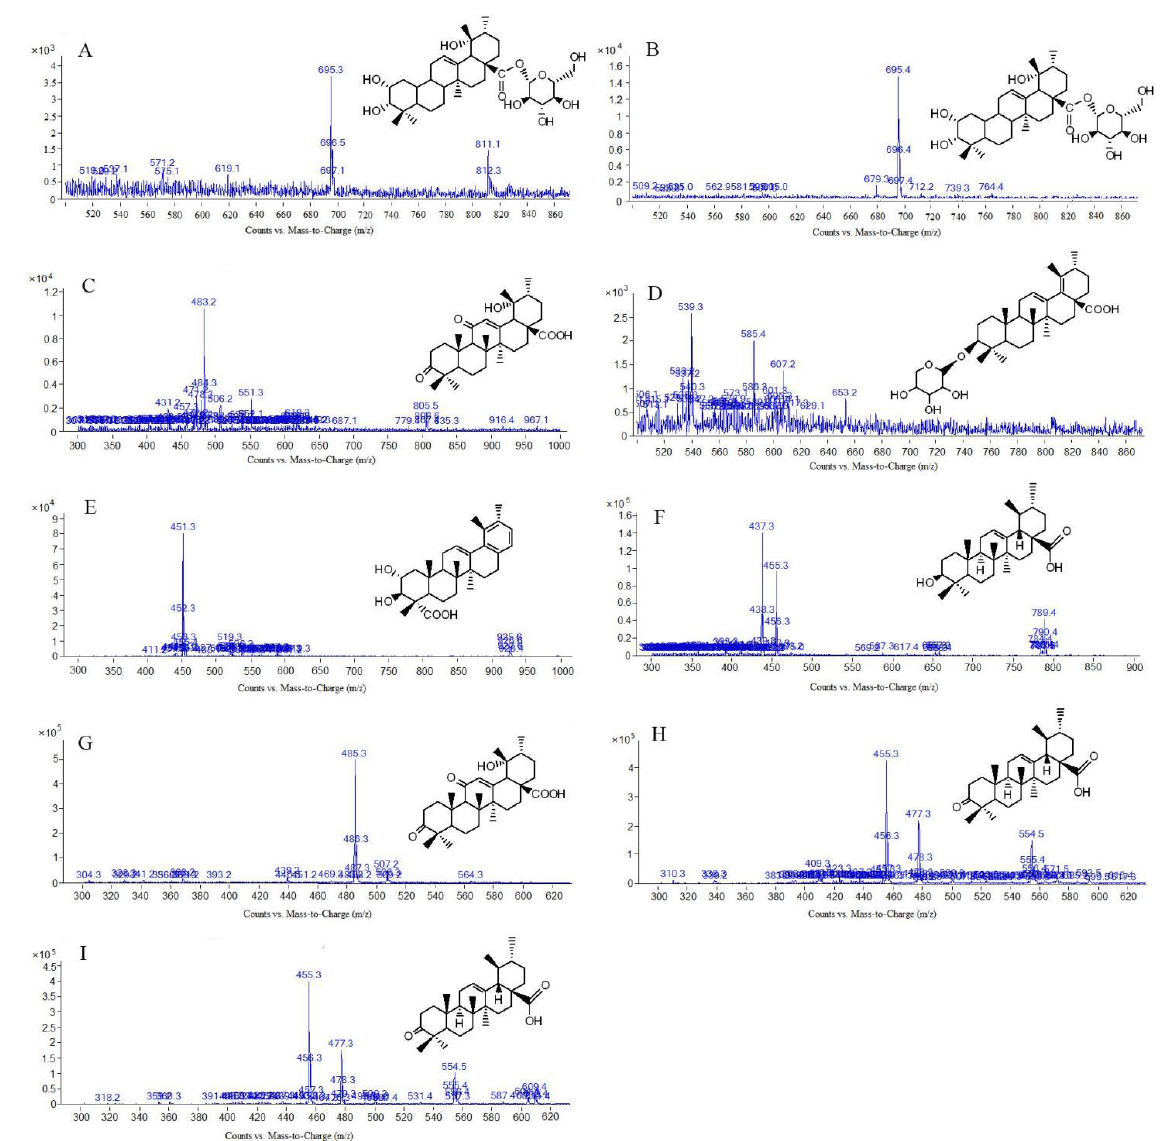
Figure 4. Mass spectrum and structure of new components in Sanguisorba officinalis L. after pro- cessing. A : 2α,3,19 -Trihydroxyurs-12-en-28-acid- β -D-glucopyranosyl ester or isomer; B : 2α,3,19 -Tri- hydroxyurs-12-en-28-acid- β -D-glucopyranosyl ester or isomer; C : 3,11-dioxo- 19α -hydroxy-urs-12- en-28-oic acid; D : 3β -O- α -L-arabinopyranosylusr-12,18-dien-28-acid; E : 2α,3β -dihydroxy-28-no- rurs-12,17,19(20),21-tetraen-23-oic acid; F : ursolic acid; G : 3,11-dioxo-1 9α -hydroxy-urs-12-en-28- acid; H : 3-oxo-12-en-28-ursolic acid or isomer; I : 3-oxo-12-en-28-ursolic acid or isomer.